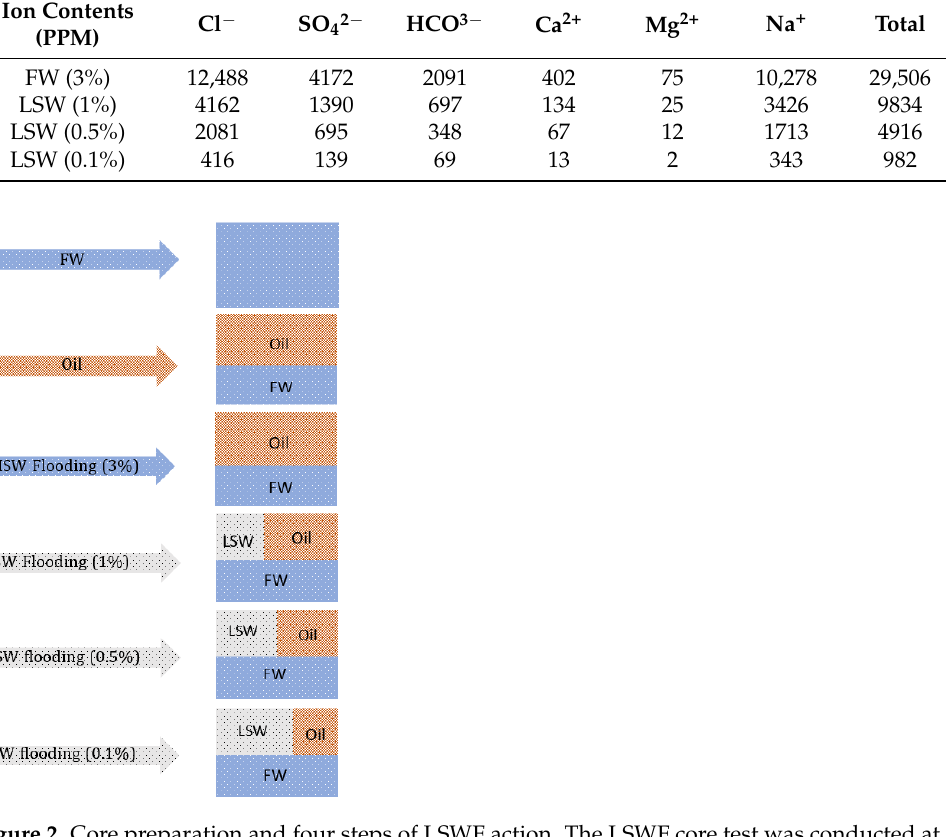
Figure 2. Core preparation and four steps of LSWF action. The LSWF core test was conducted at a condition of 60 °C which was the same as the Kashkari oil field temperature, along with the confining pressure of 20,684 kPa and a flow count of 0.2 mL/min.